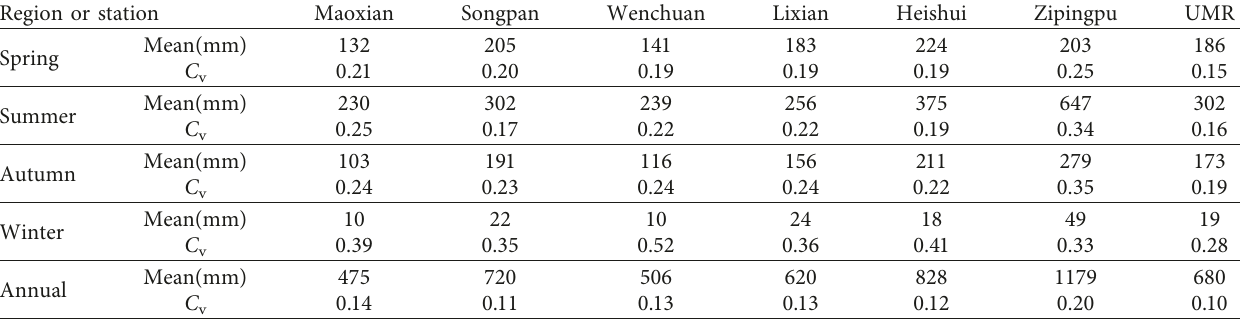
Table 2: Statistical parameters of seasonal and annual